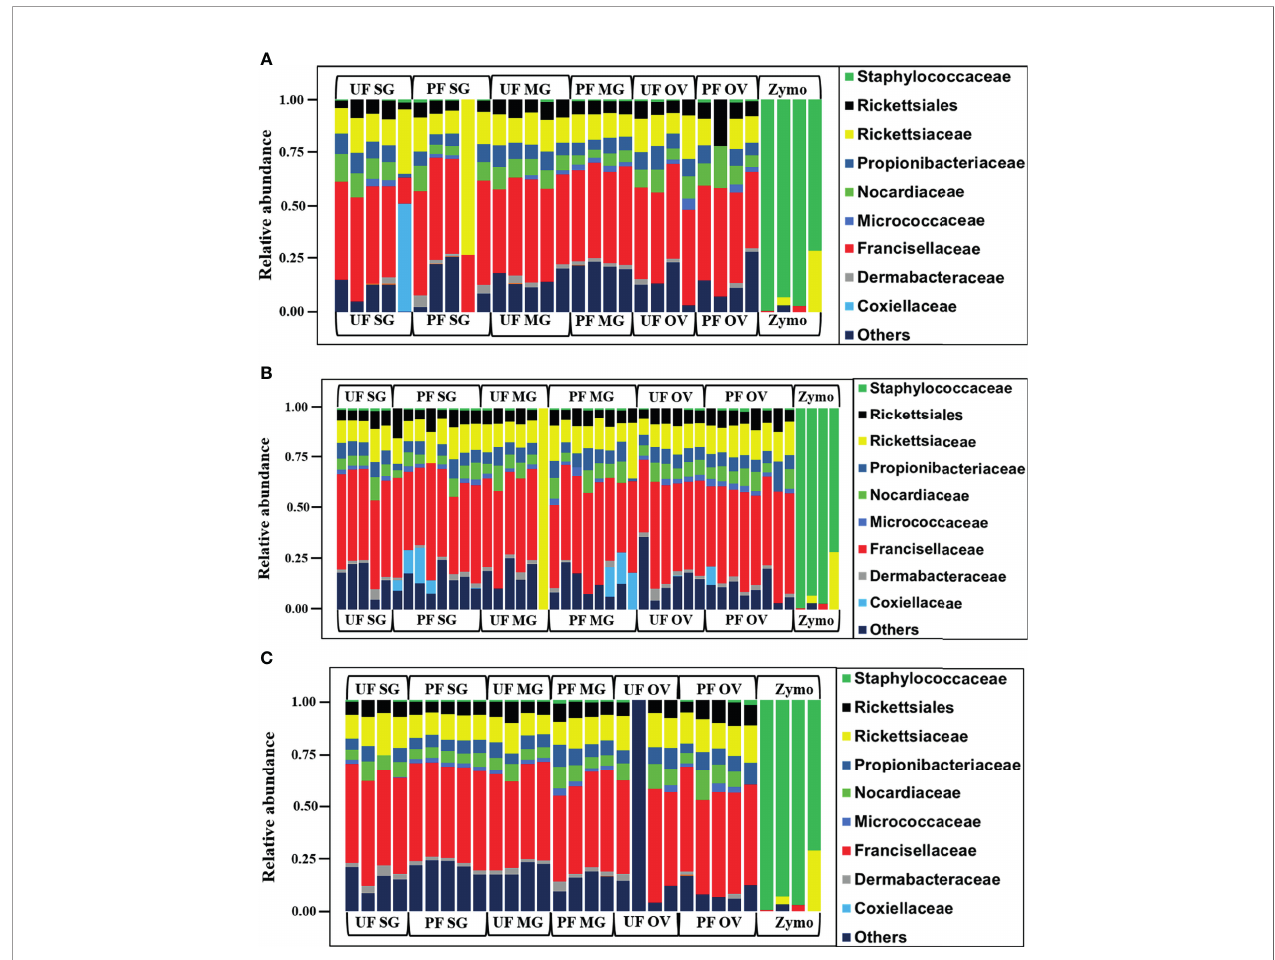
FIGURE 3 | Relative abundances of bacteria pro fi les showing the topmost abundant bacteria families to the right of the graphs. Each column represents a single replicate from different tissues isolated from unfed (UF) and partially fed (PF) Amblyomma americanum ticks collected from (A) Illinois, (B) Delaware, and (C) Maryland. All ticks displayed a similar microbial pro fi le with Francisellaceae being the most abundant family (26% – 60%). The family Nocardiaceae, Rickettsiaceae, Propionibacteriaceae, and Rickettsiales were also present in relatively equal abundance in ticks from all three geographical locations. Three individual replicates each belonging to the partially fed salivary gland and midgut (PF-SG and PF-MG) from Delaware both have Coxiellaceae identi fi ed in their microbial composition. (UF, unfed; PF, partially fed; SG, salivary gland; MG, midgut; OV, ovary; Zymo, positive bacteria